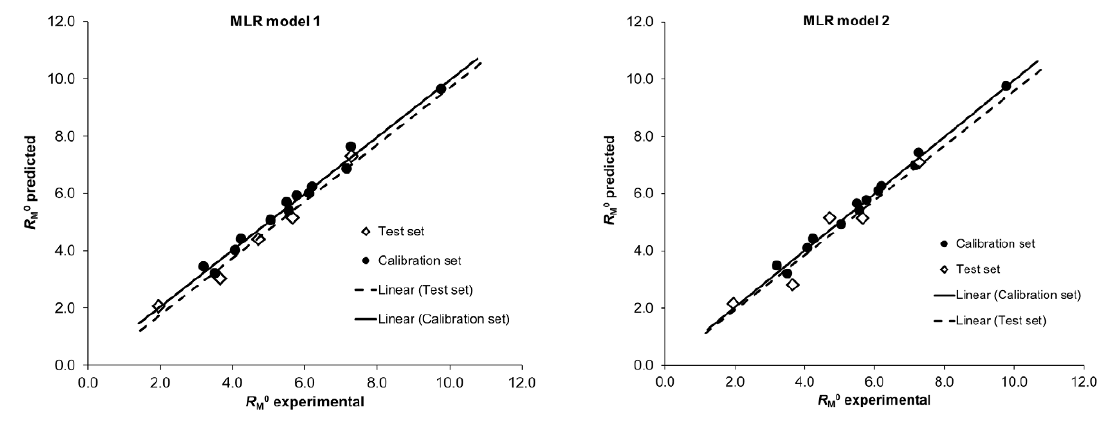
Figure 2. Graphs of experimental versus predicted R